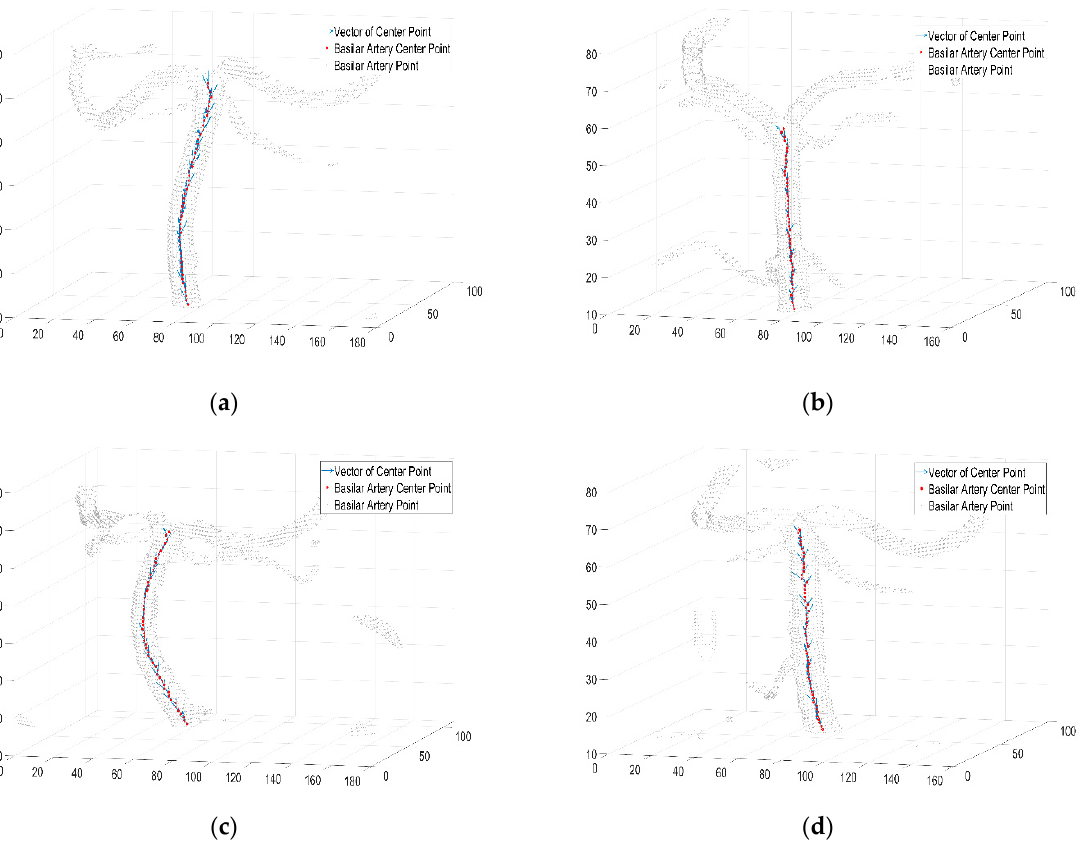
Figure 4. ( a – d ) Vector plot of bending degree of basilar artery calculated as dot product of vectors. ( a ) person A; ( b ) person B; ( c ) person C; ( d ) person D (size).